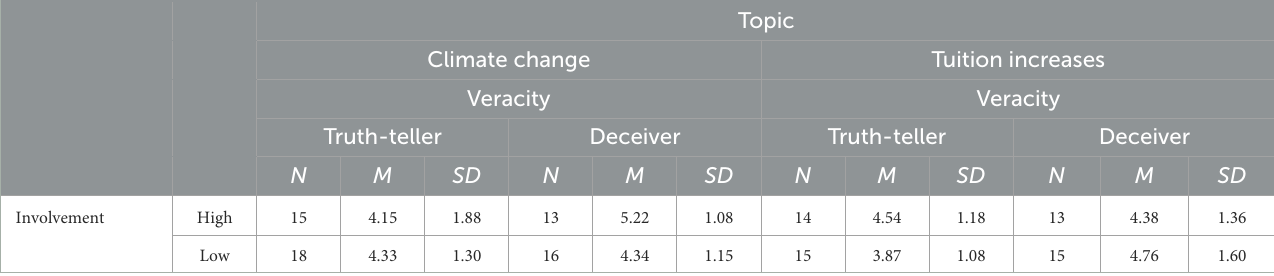
TABLE 2 Means and standard deviations for the three-way interaction among involvement, topic, and veracity in predicting participants’ perceptions of how much their partner initiated synchrony during the specific discussion of climate change or tuition increases.